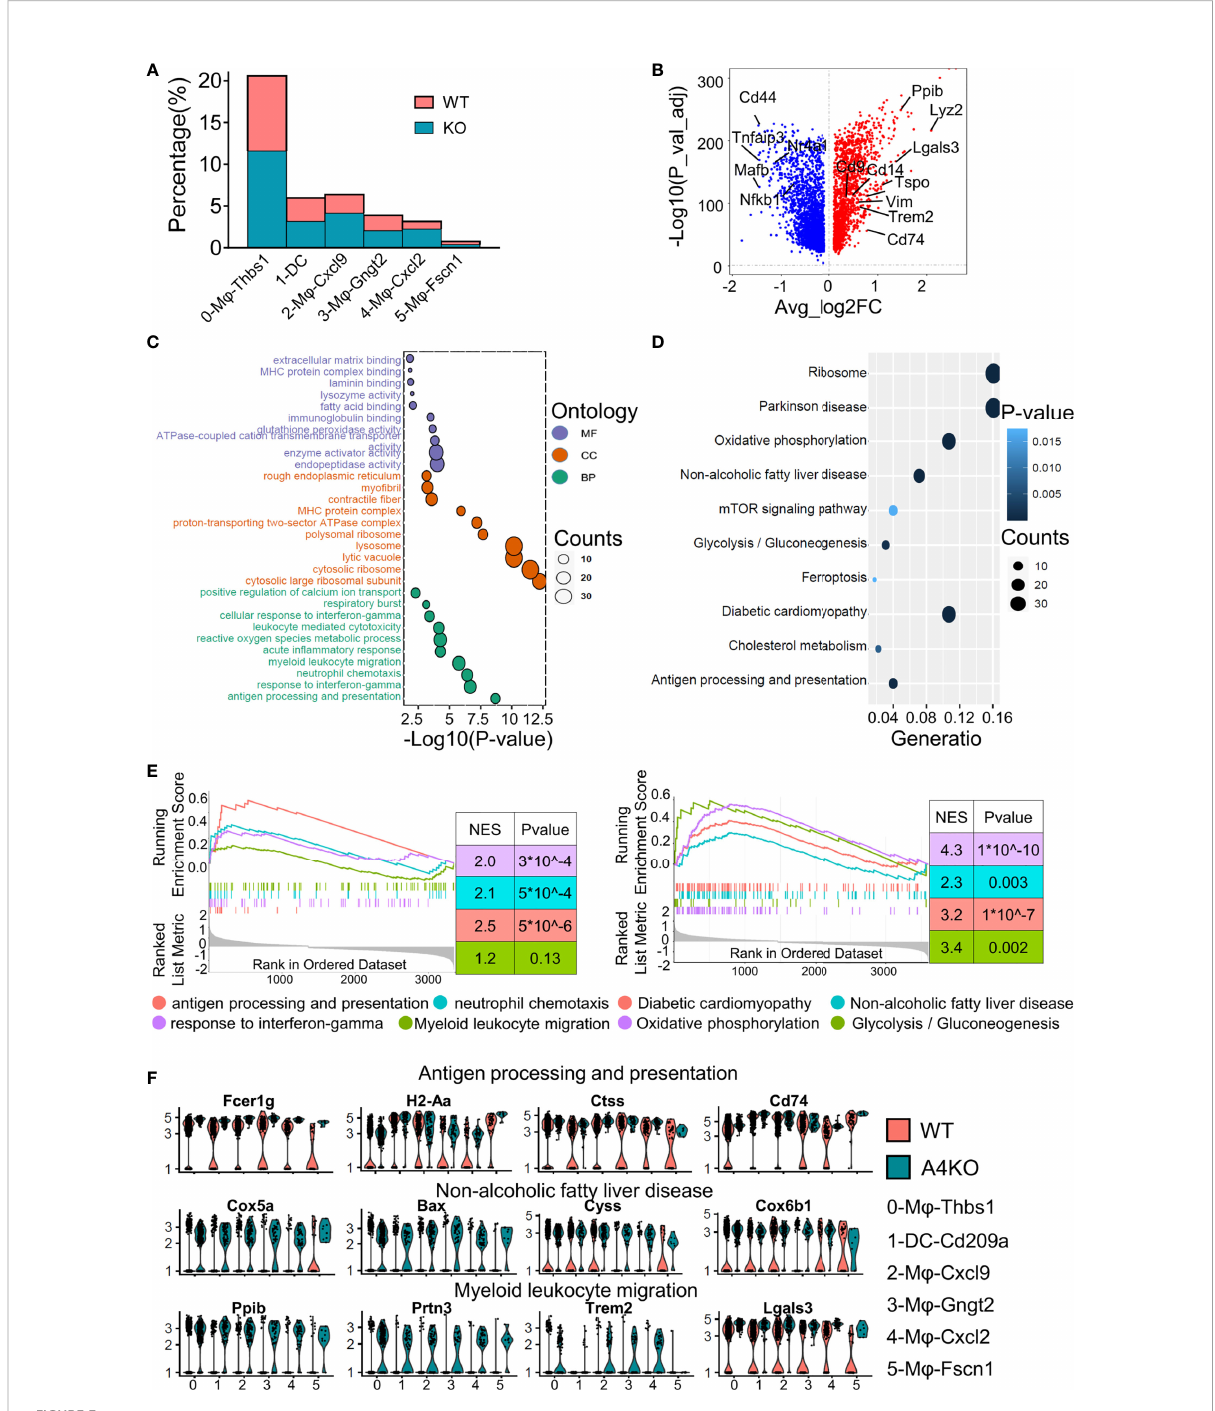
FIGURE 3 Gene expression heterogeneity and gene expression upregulation by ApoA4 knockout in macrophages and DCs. (A) Fraction of each macrophage and DC subset in WT and KO mice. (B) Volcano plot showing DEGs in macrophages and DCs between WT and KO mice. Genes upregulated in WT are shown in blue. GO (C) and KEGG (D) analyses, respectively, with the gene set in (B) , cut-off = 0.5. (E) GSEA plots of enriched pathways upregulated in KO macrophage and DC subsets. (F) Violin plots showing the expression of function-related genes in (C, D) across six